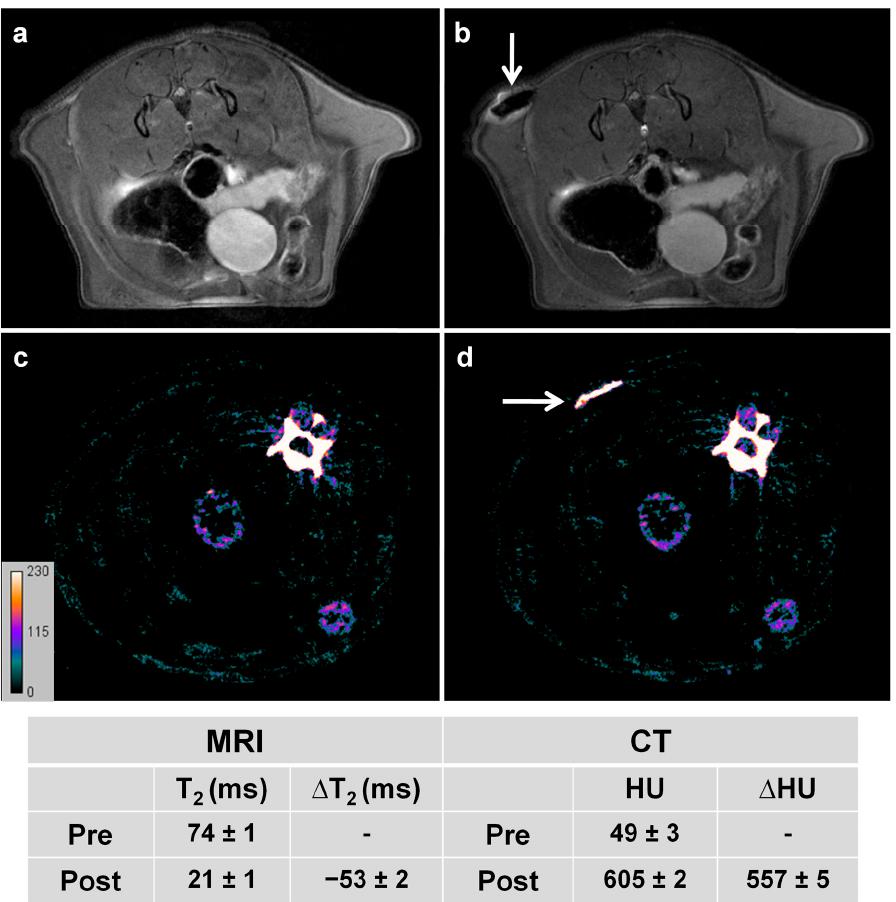
Figure 6. Representative in vivo images before ( a , c ) and after ( b , d ) subcutaneous administration of Fe@Au NPs. Top: T 2 -weighted images; bottom: CT images. Arrows indicate NPs location. The table collects the corresponding Δ T 2 and Δ HU values.